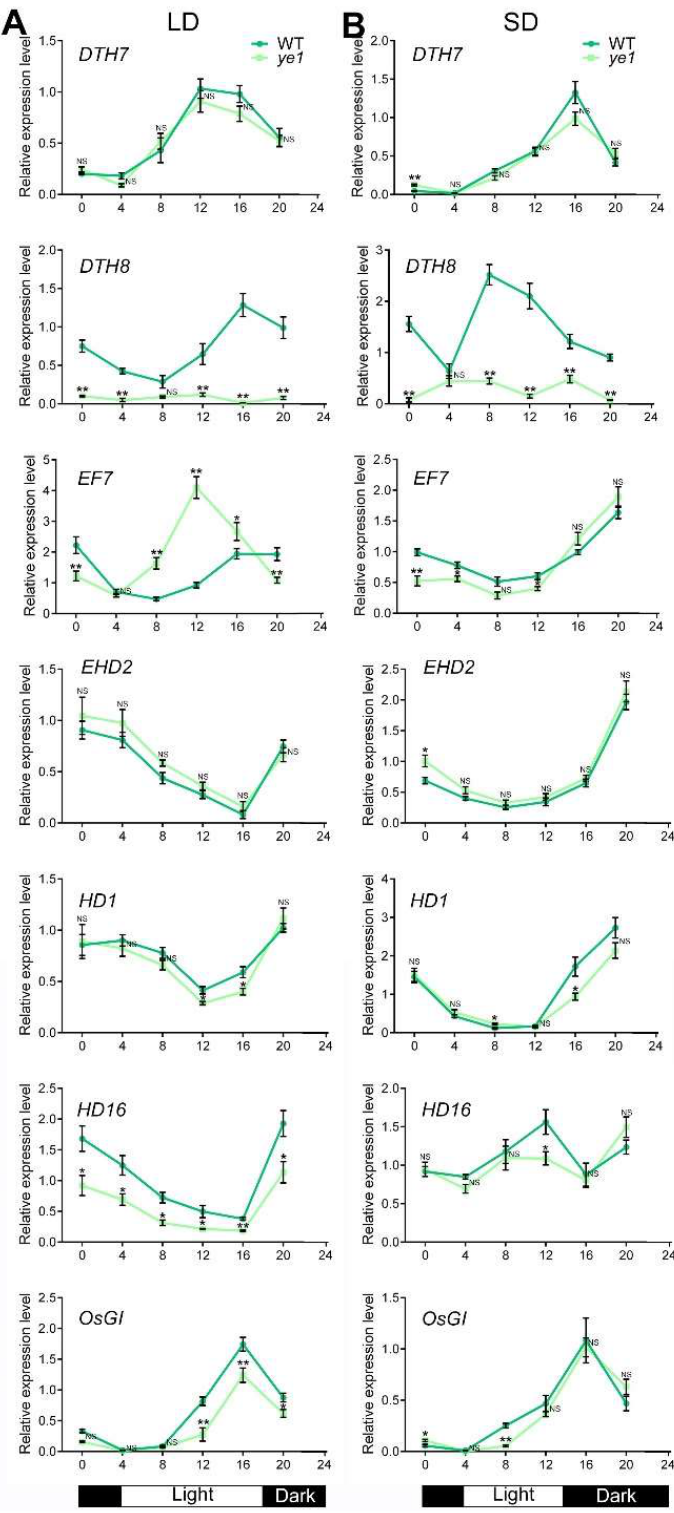
Figure 8. Rhythmic expression patterns of photoperiodic flowering-associated genes in WT and ye1 . ( A ) Rhythmic expression patterns of DTH7 , DTH8 , EF7 , EHD2 , HD1 , HD16 , and OsGI under LDs. ( B ) Rhythmic expression patterns of DTH7 , DTH8 , EF7 , EHD2 , HD1 , HD16 , and OsGI under SDs. Each value is given as means ± SEM ( n = 3). NS, no significant change. * ( p < 0.05) and ** ( p < 0.01) indicate significant differences compared with WT (Student’s t -test).